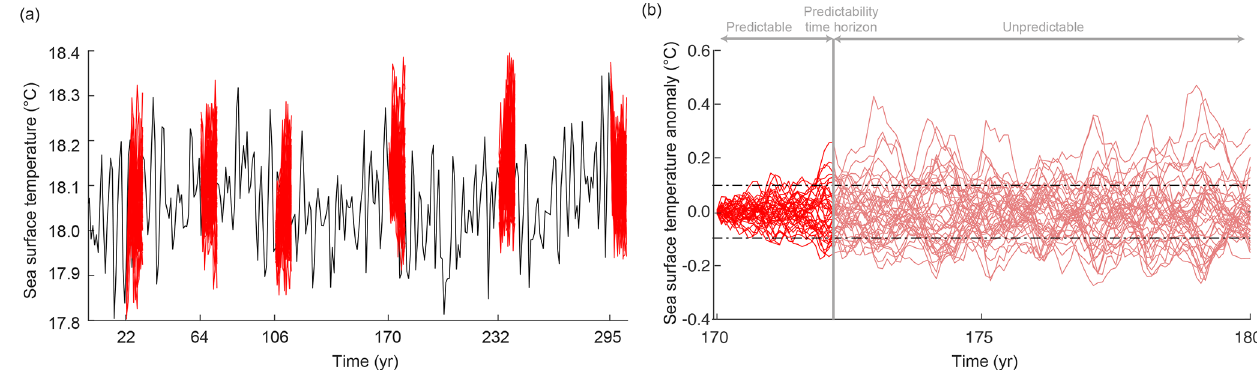
Figure 1. Illustration of the model setup and the calculation of the predictability time horizon. (a) Simulated global mean SST of the 300-year reference control simulation (black line) and of the six 10-year-long 40 ensemble simulations (red lines). (b) Global mean SST anomaly (i.e., deviation from the control simulation) for the ensemble simulation starting in the year 170. The thick red line indicates the period over which SST is predictable (i.e., PPP ≥ 0 . 183), and thin red lines indicate the period over which SST is unpredictable (i.e., PPP < 0 . 183). The dashed horizontal lines indicate 1 standard deviation of the control simulation, and the vertical line indicates the predictability time